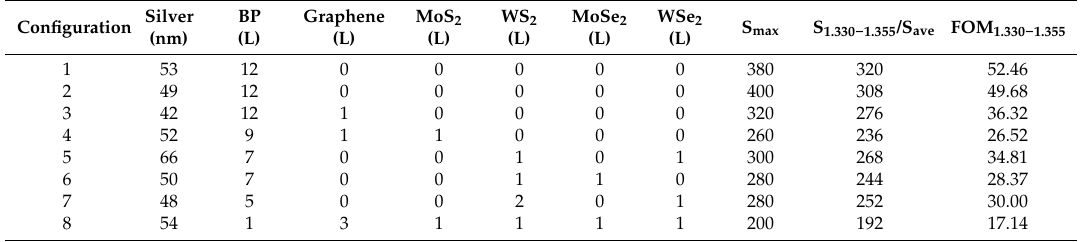
Table 5. Optimization